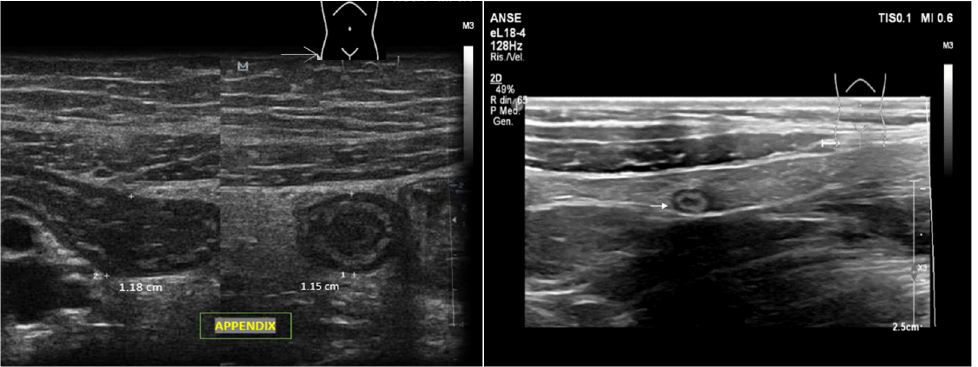
Figure 10. Ultrasonography of normal and abnormal appendixes. On the left, there are longitudinal and transverse USs of acute appendicitis showing thickened walls and diameter > 6 mm. On the right, there is a thinner normal appendix.